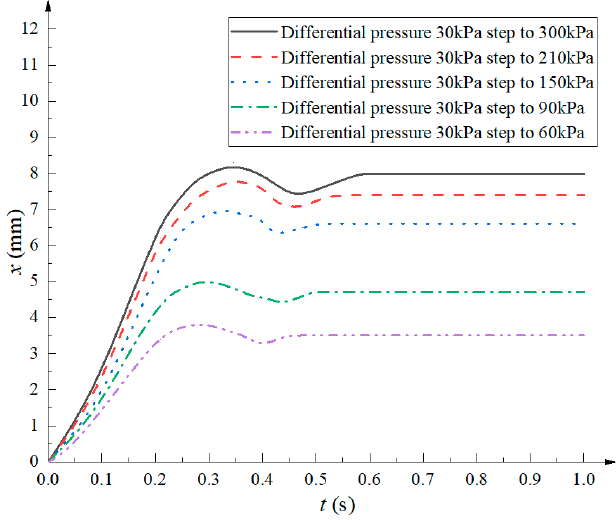
Figure 9. Valve core displacement dynamic characteristic curve.